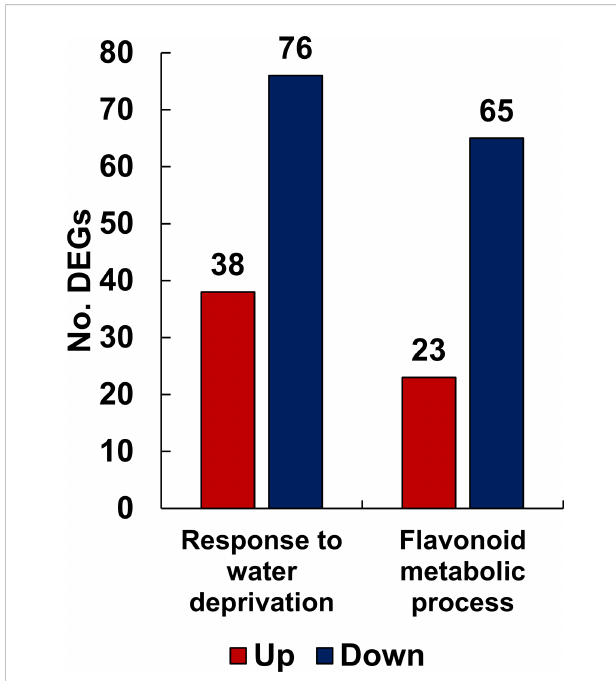
FIGURE 3 The number of up- and down-regulated DEGs related to response to water deprivation and fl avonoid metabolic process functionally categorized by GO analysis from L. fi scheri under drought stress. The x-axis represents the number of DEGs and the y-axis indicates each subcategory ’ s information. In bar graphs, red and blue colors are shown as up- and down-regulated DEGs, respectively.